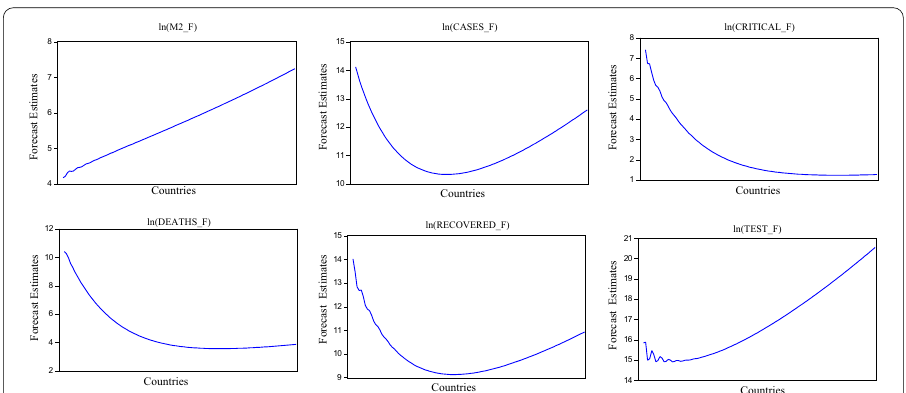
Fig. 2 Overall forecast trend. Note: ’ln’ shows natural logarithm, ’F’ shows forecasted value, M2 shows broad money supply, CASES_F shows COVID-19 registered cases, DEATHS show COVID-19 death cases, RECOVERED shows COVID-19 recovered cases, CRITICAL shows COVID-19 critical cases, and TEST show COVID-19 testing